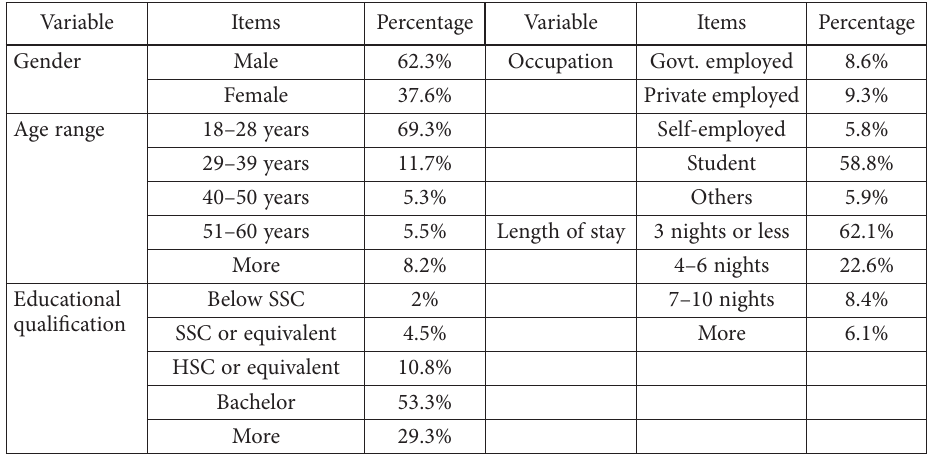
Table 1. Demographic characteristics ( n = 443) (source: survey data)